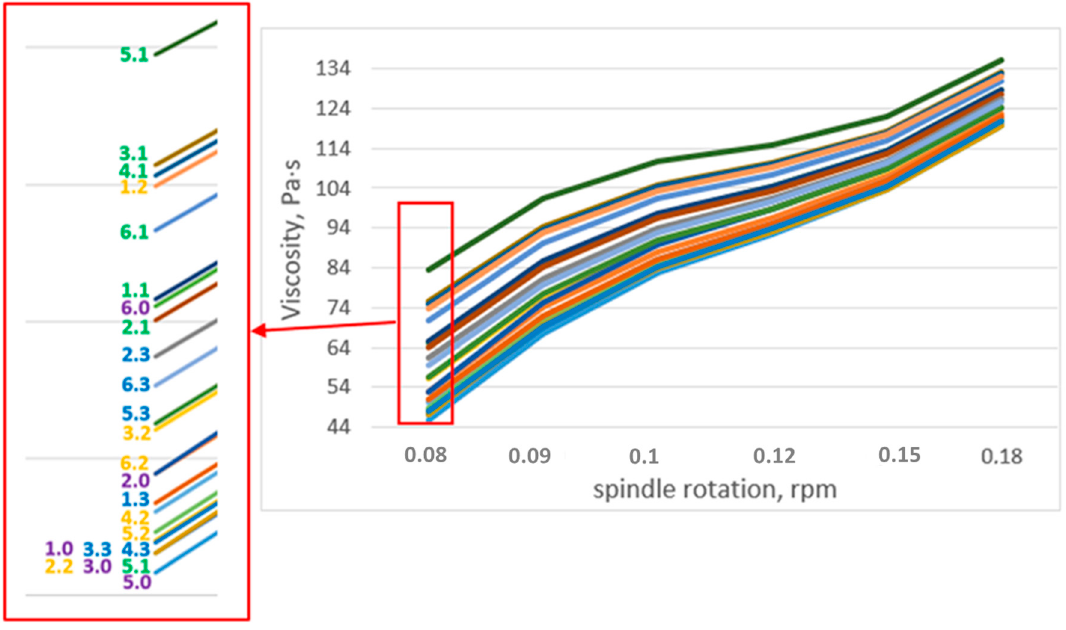
Figure 3. Dependence of the viscosity of fertilizer suspensions on the rotational speed of the meas- uring spindle